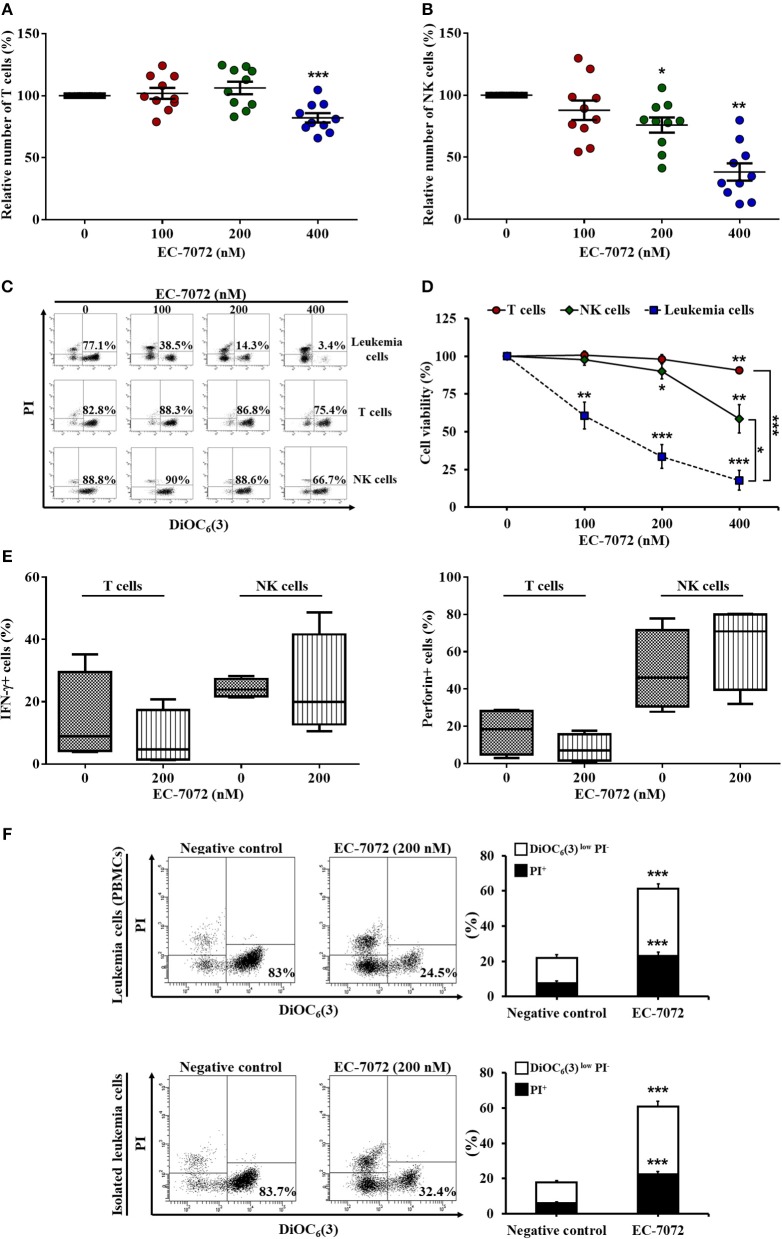
EC-7072 shows reduced toxicity on healthy immune subsets from patients with CLL. PBMCs from patients with CLL (n = 10) were incubated with increasing concentrations of EC-7072 (0–400 nM) for 24 h. Numbers of T cells (CD3+CD56−) (A) and NK cells (CD3−CD56+) (B) were evaluated by flow cytometry. Graphs represent the number of cells normalized to their respective control (DMSO) condition for each individual patient and dark lines correspond to mean ± SEM. (C,D) PBMCs from patients with CLL (n = 6–10) were incubated with increasing concentrations of EC-7072 (0–400 nM) for 24 h and viability of immune subsets (leukemia cells, T cells, and NK cells) was determined by cytofluorometric assessment of DiOC6(3)/PI staining. Dot plots depict a representative patient with CLL and percentages within refer to viable [DiOC6(3)+] cells (C). Graphs represent the percentage of viable [DiOC6(3)+] cells normalized to their respective control (DMSO) condition (D). (E) IFN-γ and perforin expression upon PMA/ionomycin stimulation was evaluated in T cells and NK cells by intracellular flow cytometry in PBMCs from patients with CLL (n = 4) exposed to EC-7072 (200 nM) for 24 h. The graph depicts the percentage of IFN-γ+ or perforin+ cells, respectively. (F) PBMCs and isolated leukemia cells from patients with CLL (n = 24) were treated with EC-7072 (200 nM) for 24 h and apoptosis was examined by DiOC6(3)/PI staining. Dot plots depict a representative patient and percentages within refer to viable [DiOC6(3)+] cells. Bars represent the percentages of apoptotic [DiOC6(3)low PI−] and dead [PI+] cells (mean ± SEM) (*P < 0.05; **P < 0.01; ***P < 0.001; Student's t-test).